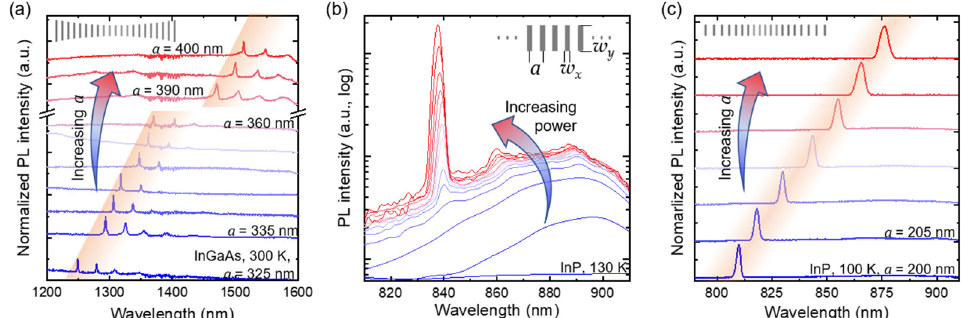
Figure 4. ( a ) Emission spectra for hybrid InGaAs/Si PhC cavities with different lattices measured at room temperature. The cavity design is displayed in the inset. Simulated emission wavelengths for each PhC cavity are marked by a shaded area due to an uncertainty on the refractive index of III-Vs. Reprinted and adapted with permission from [33] © 2020 American Chemical Society. ( b ) PL intensity for a hybrid InP/Si PhC cavity under increased optical pumping at 130 K in logarithmic scale, showing the emergence of a resonant mode at higher pump powers. ( c ) Emission wavelength dependency of InP-based cavities with a slightly different cavity design and for regularly increasing lattice constant, measured at 100 K.